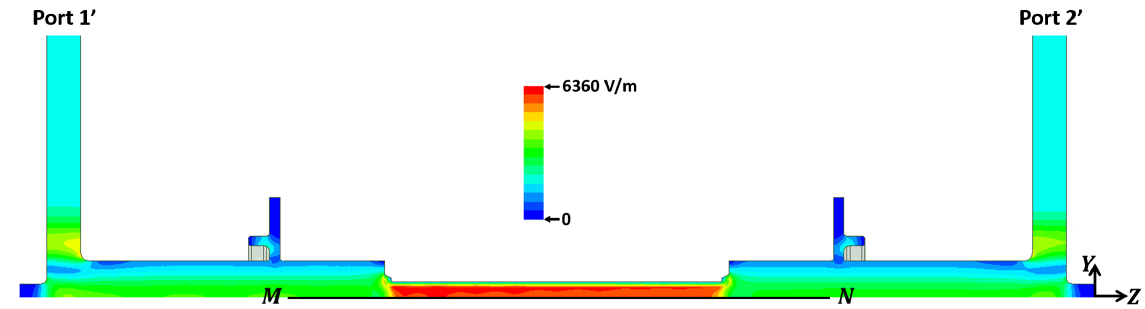
FIG. 10. Electric field distribution for the full-assembly structure with a quarter geometry, where line MN is located on the center along the